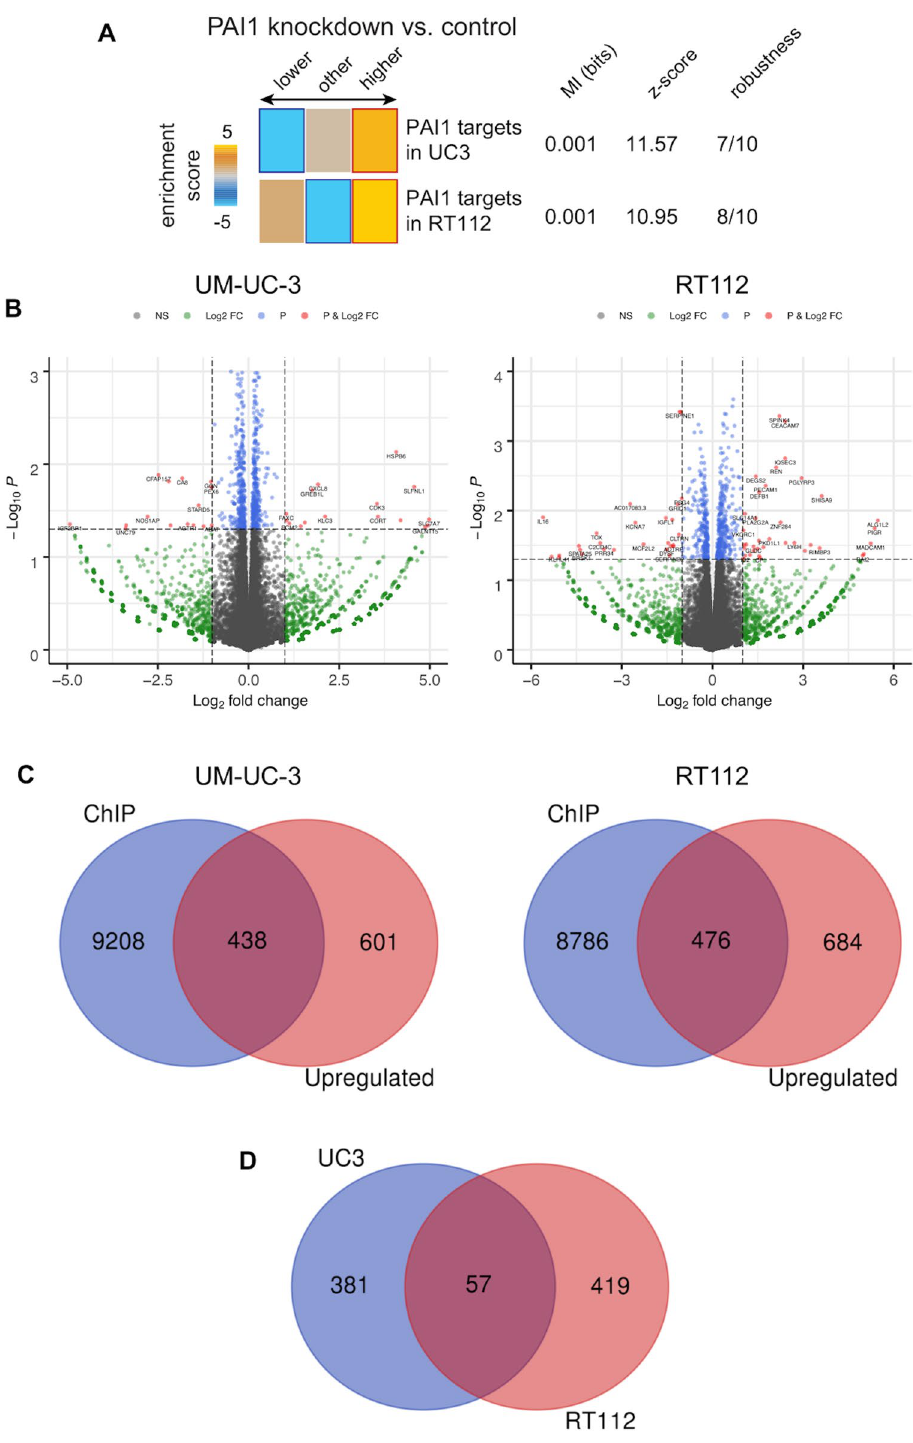
Figure 3. Gene expression profiling by RNA-seq and integration of ChIP-seq and RNA-seq. ( A ) Enrichment Analysis of RNA-seq indicate that knockdown of PAI-1 results in upregulation of the genes. ( B ) Volcano plot showing fold-change and p-value for the comparisons of negative control and PAI-1 siRNA. ( C ) Venn diagram showing the overlapping genes between ChIP-seq and upregulated genes from RNA-seq. ( D ) Venn diagram representing the overlap of nuclear PAI-1 regulating genes in UM-UC-3 and RT112